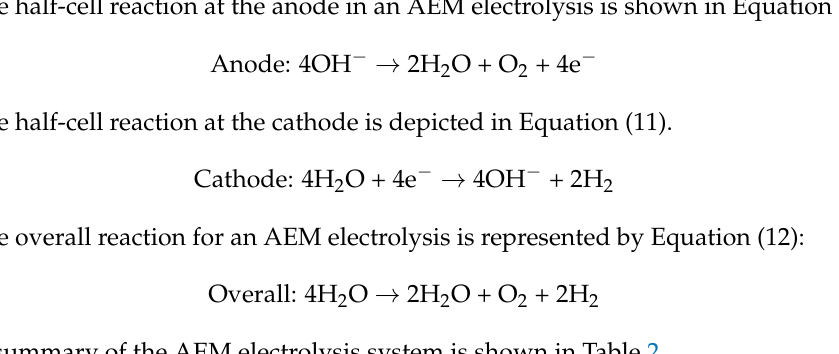
Table 2 . Summary of the AEM electrolysis system for hydrogen production .